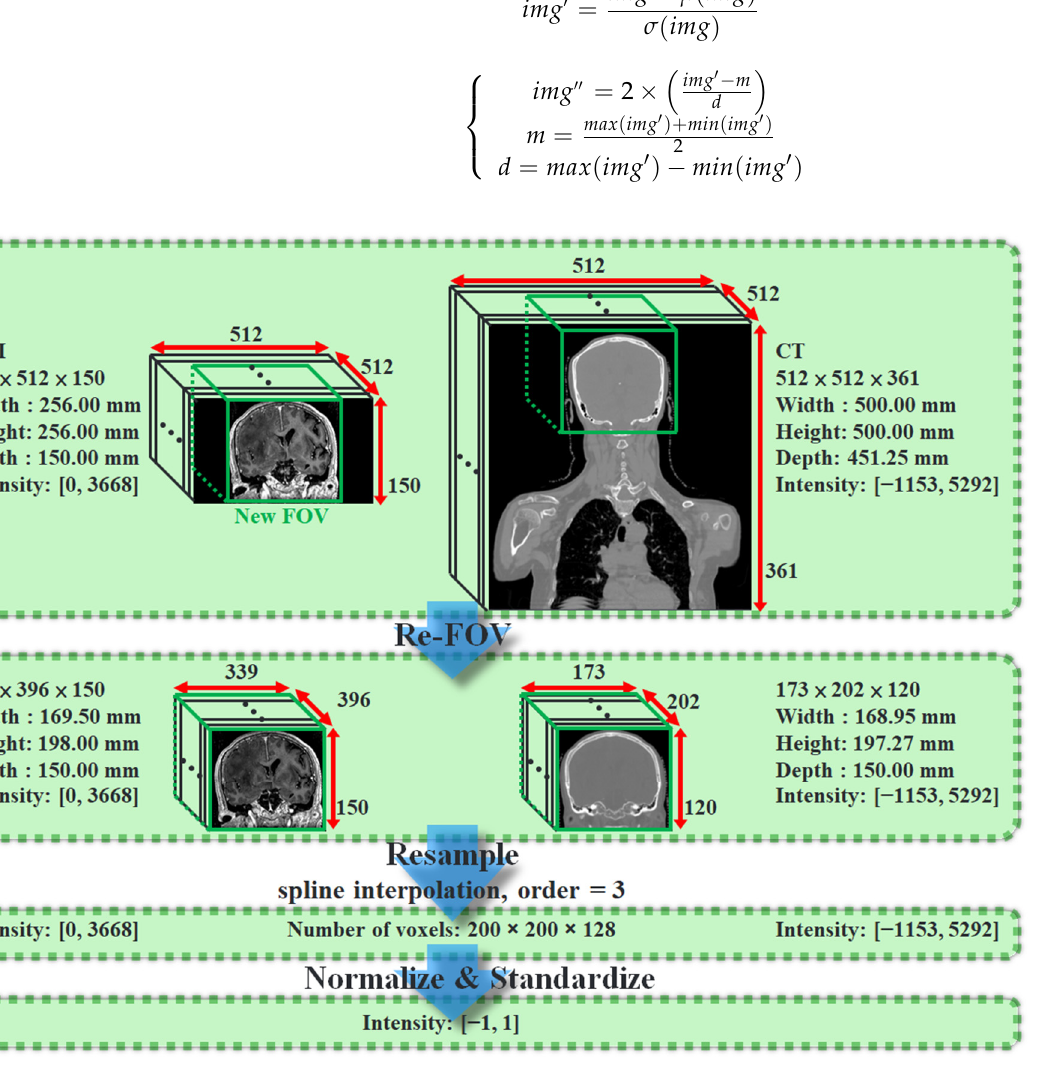
Figure 1. The workflow of data preprocessing. The parameters in Figure 1 come from one of the real cases in the original dataset. The workflow is applied to all pairs of original